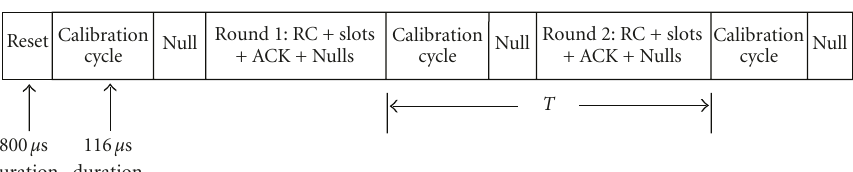
Figure 4: m -ASAP round